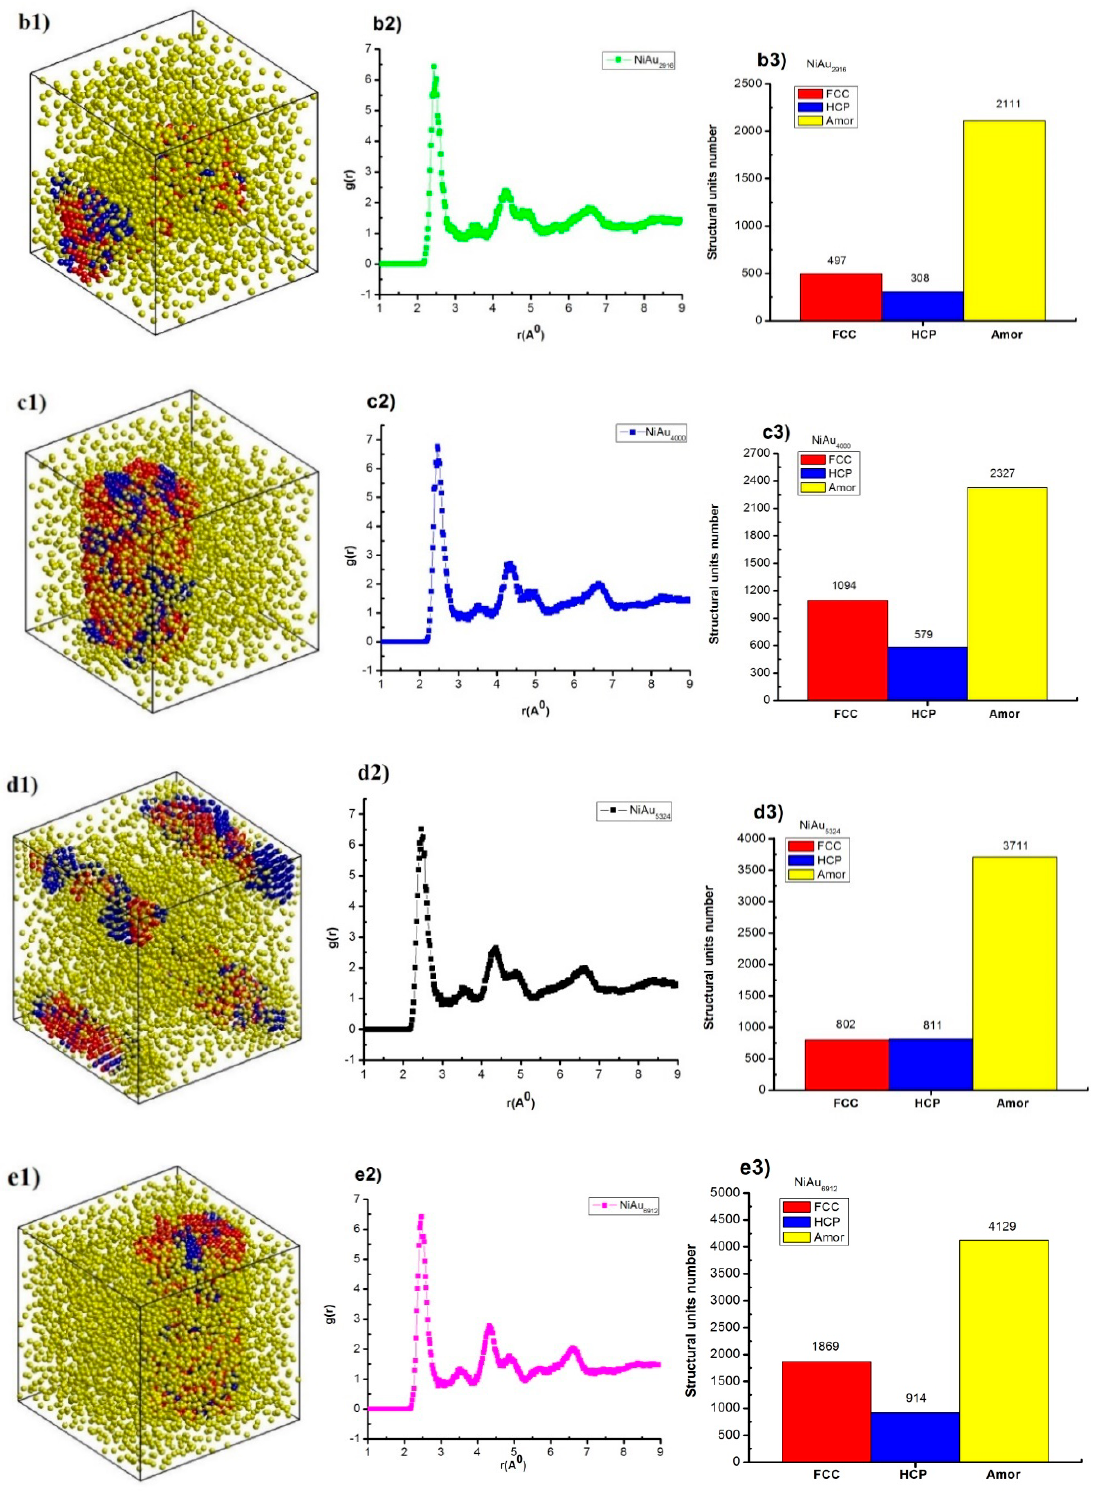
Figure 4. The structural shape ( a1 , b1 , c1 , d1 , e1 ), radial distribution function (RDF) ( a2 , b2 , c2 , d2 , e2 ), structural unit number ( a3 , b3 , c3 , d3 , e3 ) of NiAu alloy with different N. The results indicate that NiAu 2048 alloy at T = 300 K has structural shape and l = 7.34 nm, E tot = − 173.85 eV (Figure 4(a1)), together with the radial distribution function, has r = 2.49 Å, g(r) = 6.47 (Figure 4(a2)), and the structural unit numbers are 312 FCC, 443 HCP, 1293 Amor (Figure 4(a3)). When increasing atoms number from NiAu 2048 to NiAu 2916 ,